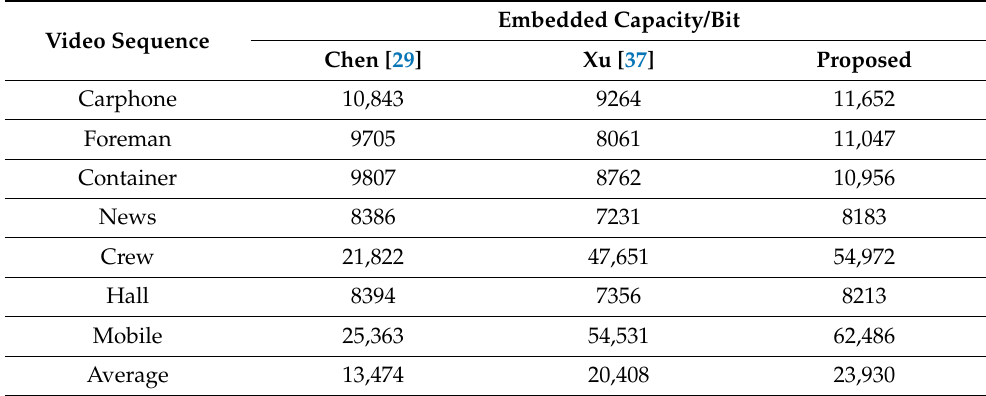
Table 1. Comparison of the embedded capacity of seven video sequences with other schemes. Video Sequence